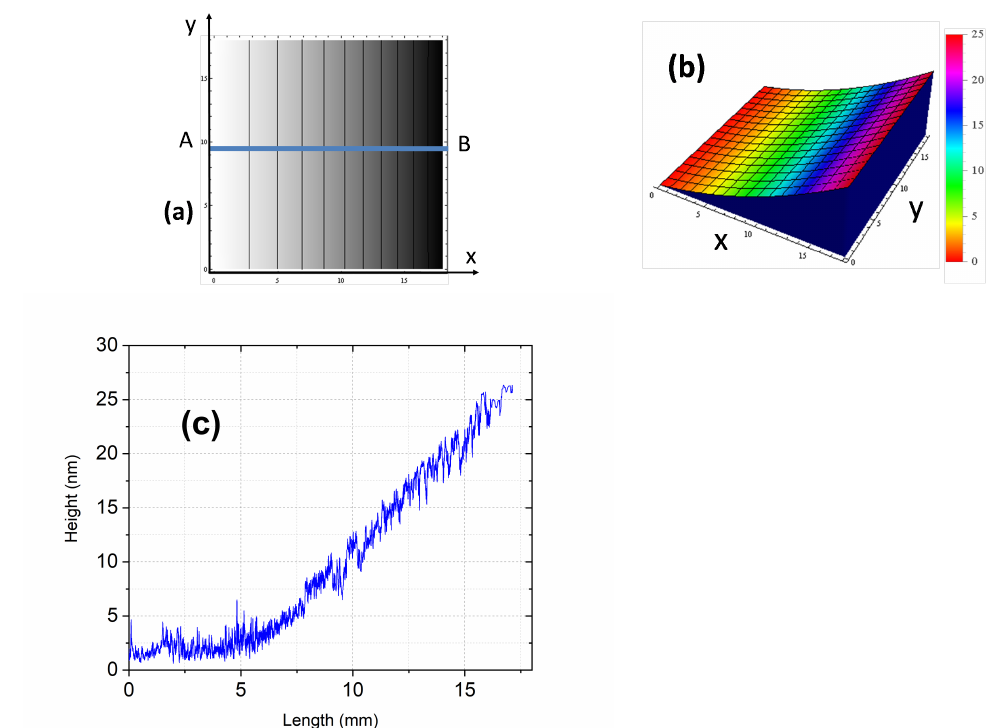
Figure 2. ( a ) The density plot outlines the expected thickness gradient profile of our sample in off-axis geometry. Blue line AB corresponds to the selected direction for measuring the sample thickness. ( b ) 3D graph simulates the surface of the Co assembly along AB direction. Color bar scale is in nm. ( c ) Thickness profile measured along AB direction. Thickness resolution was ≤ 1 nm with our profilometer (see Supplementary Material for